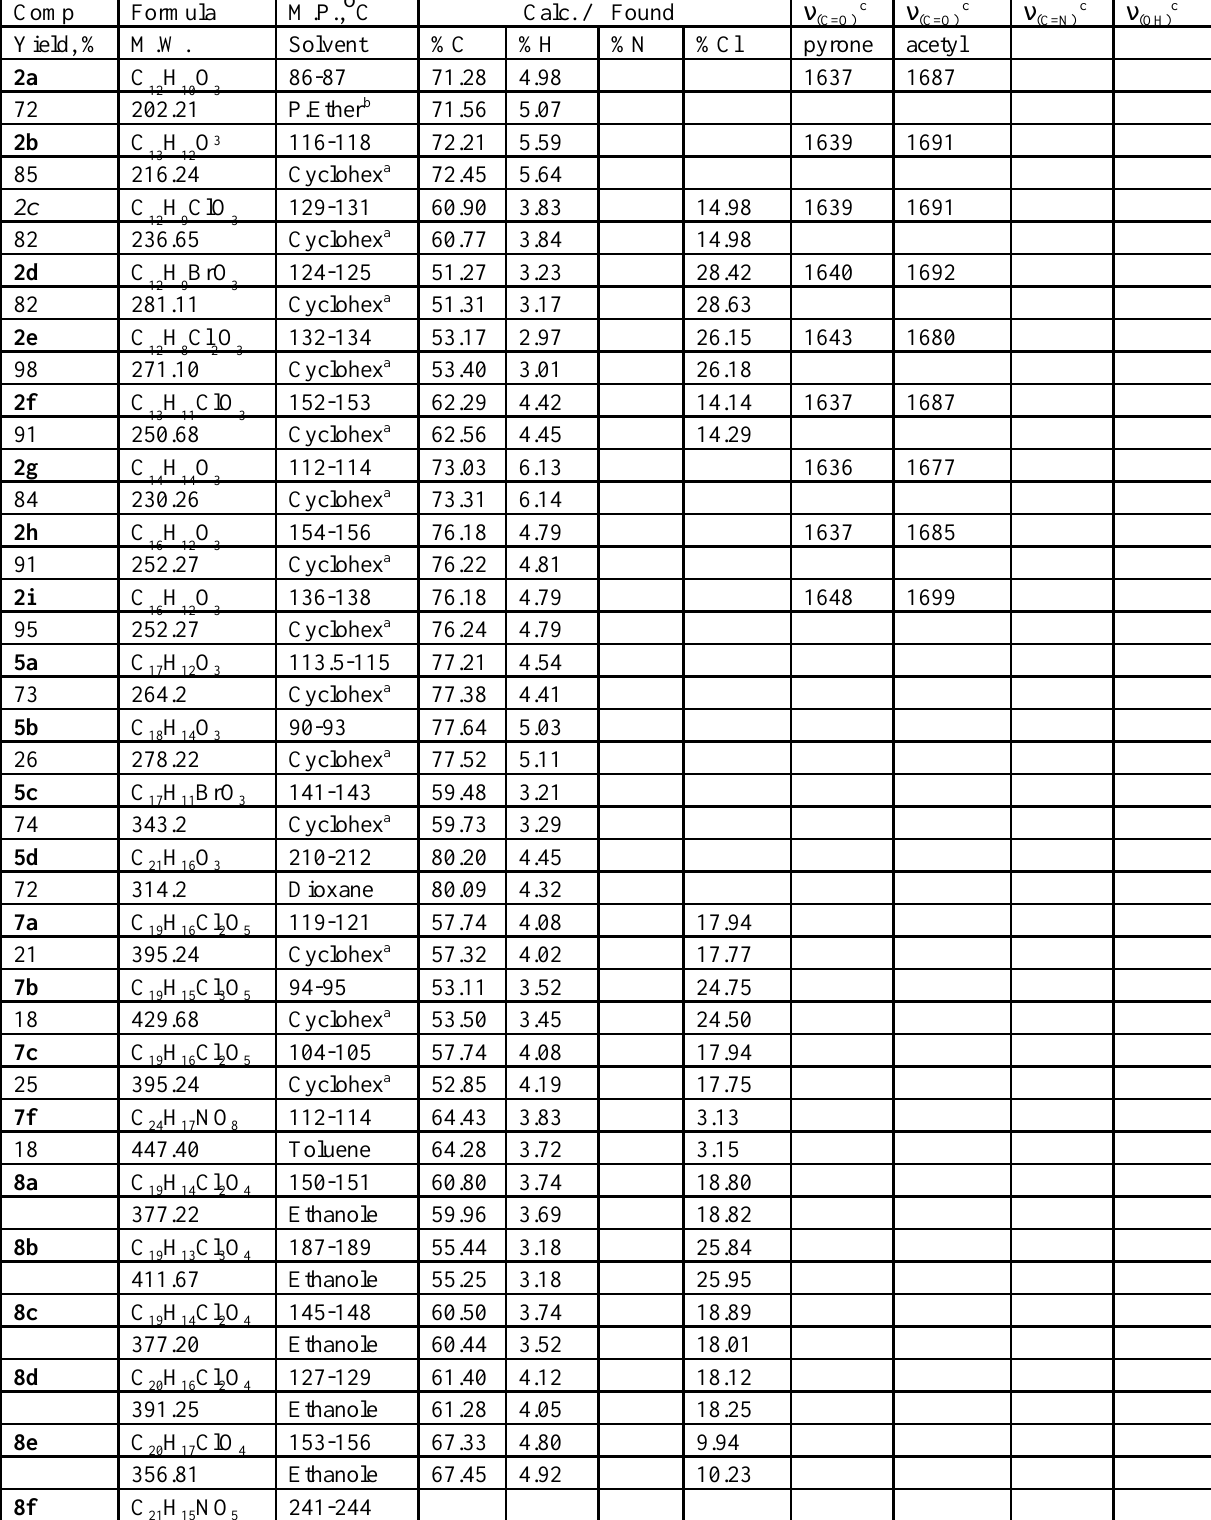
Table 1. Physical data of the prepared